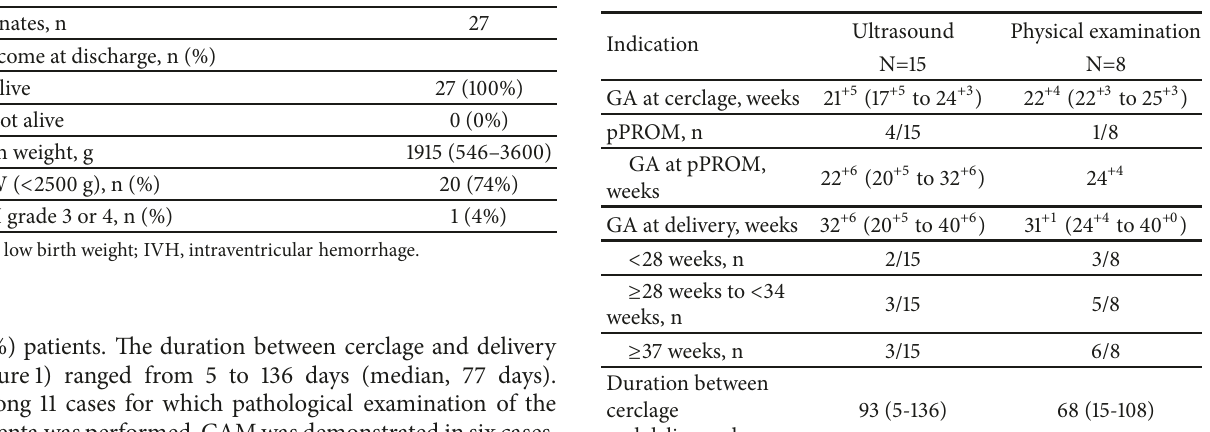
Table 4: Outcomes of live-born neonates. Table 5: Perinatal outcome, by indication for